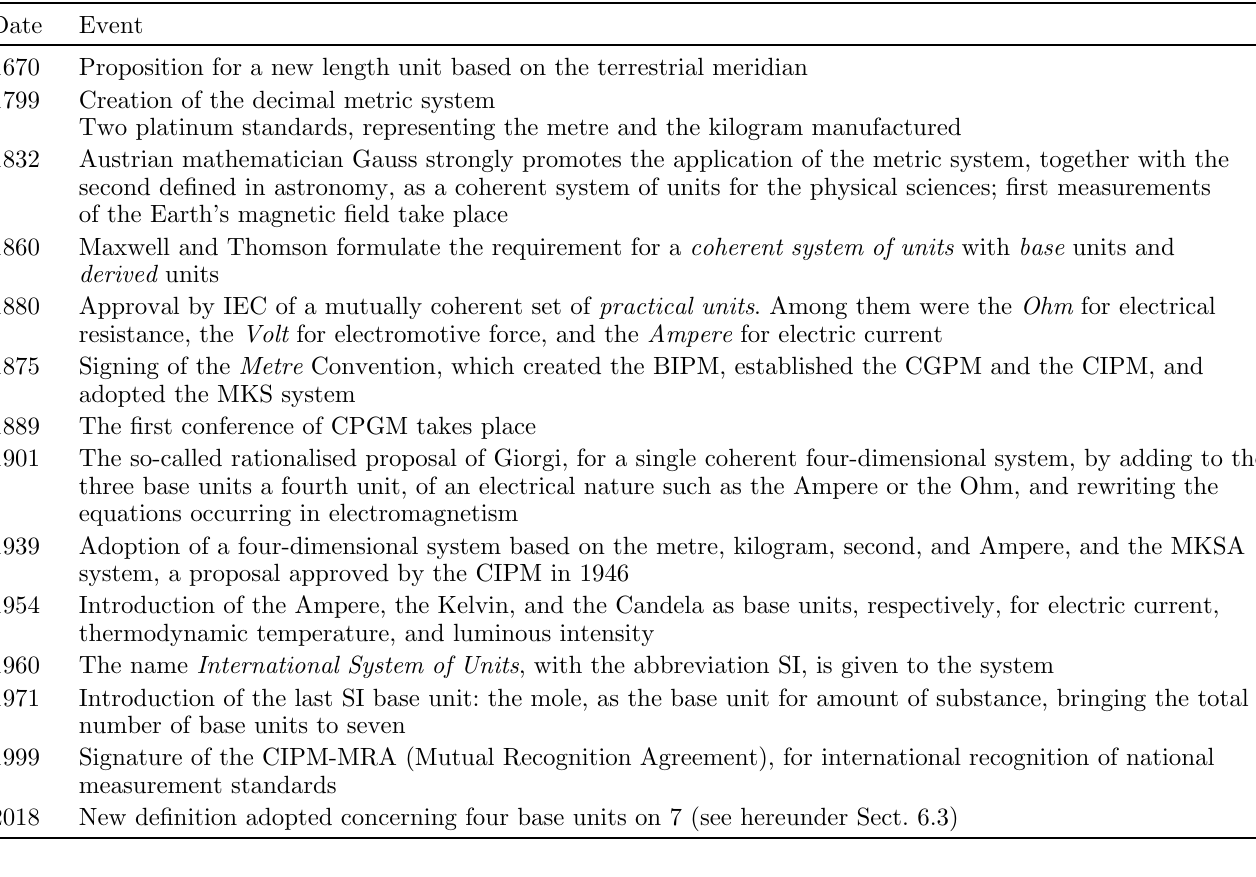
Table 1. The most important milestones of recent metrology history.